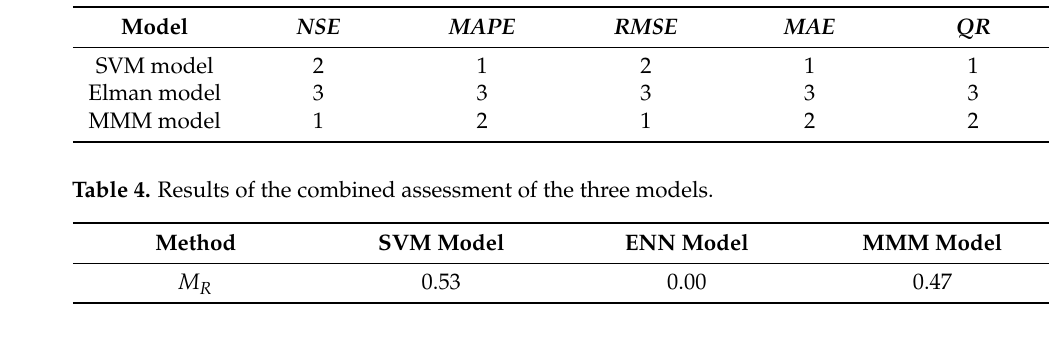
Table 5. Model stability analysis results.